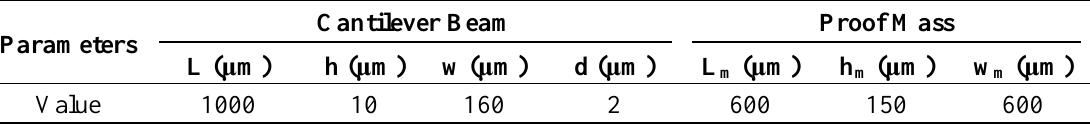
Table 8. Design parameters for the proposed